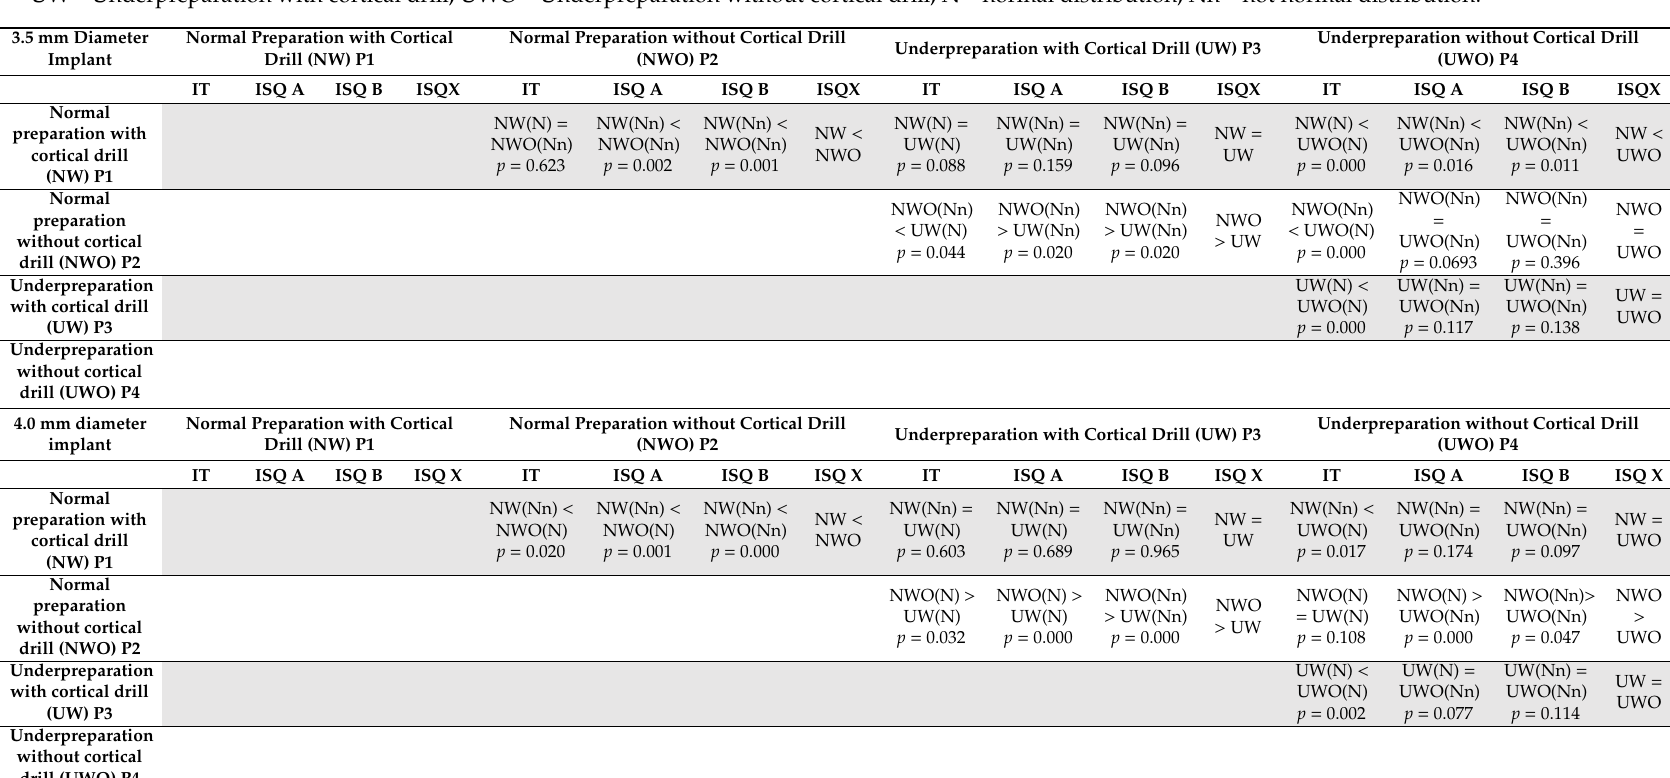
Table 3. Relationship between the di ff erent types of preparation (P1, P2, P3 and P4) for 3.5 and 4.0 mm diameter implants. T-Student and Mann–Whitney tests were applied if the variables showed a normal (N) or did not show normal distribution (Nn) respectively. IT—insertion torque; ISQ A—ISQ first